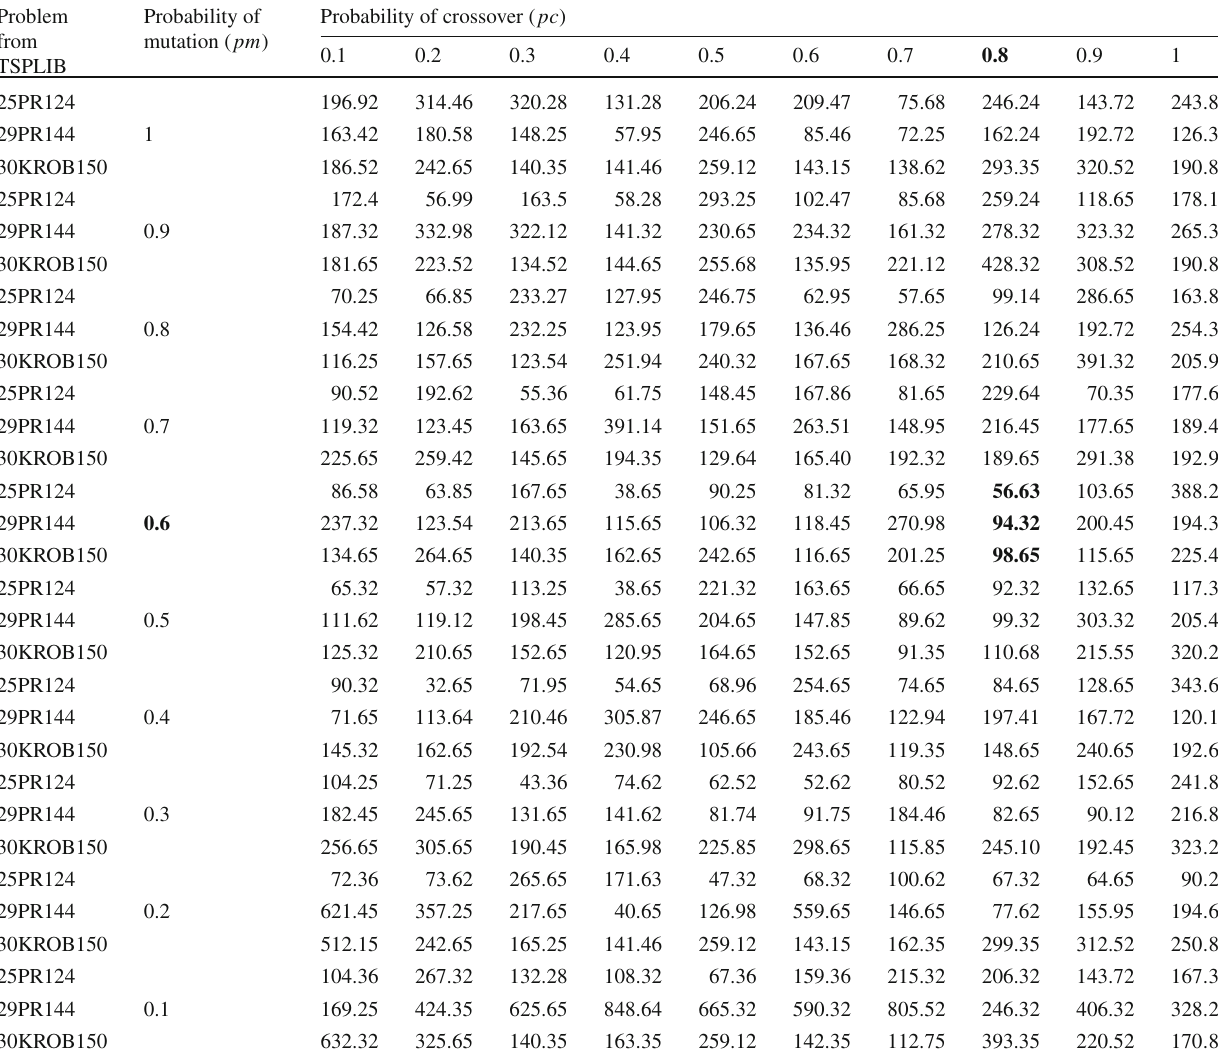
Table 6 Time required (in s) to find the optimal solution of different test problems from TSPLIB using different values of pm and pc Problem Probability of from mutation ( pm TSPLIB